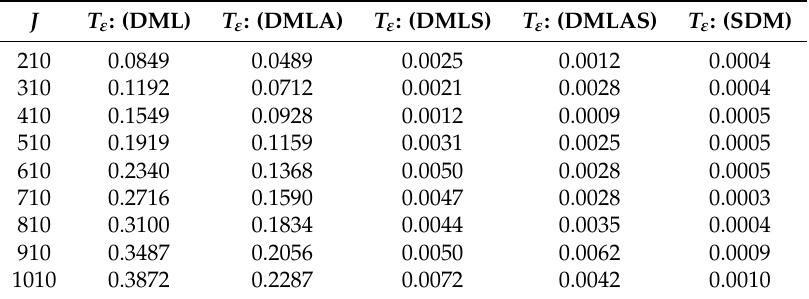
Table 2. Results for Case L with m = 25, ε = 10 − 2